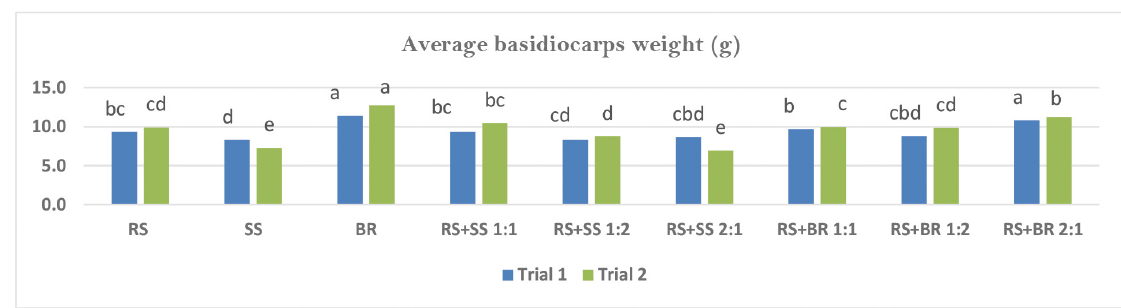
Fig. 2 Average basidiocarps weight of oyster mushroom ( P. ostreatus ) produced on three sole substrates